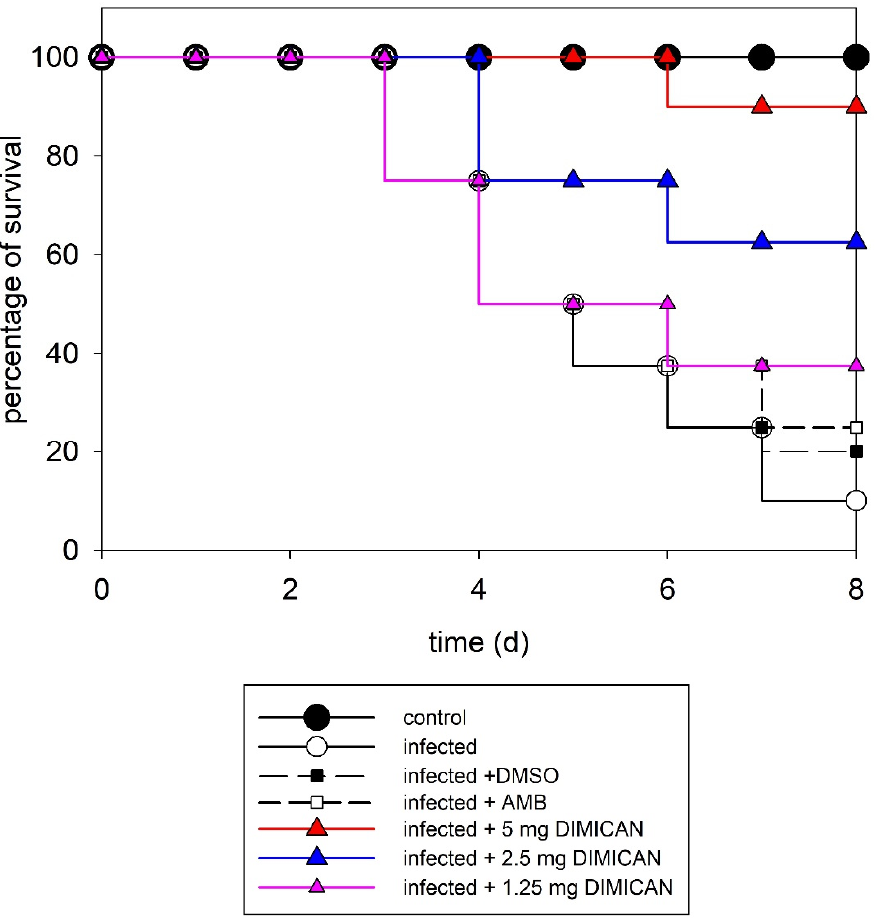
Figure 2. Survival curves for mice infected with Aspergillus fumigatus Af293. C- control, treated with DMSO, AMB or DIMICAN (D) in three different concentrations. For all groups n = 10. Number of independent experiments = 3.